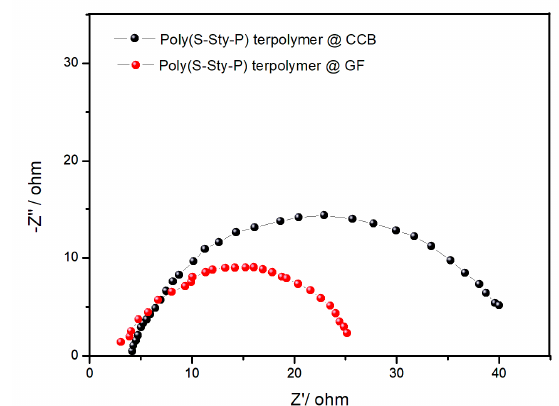
Figure 13. The electrochemical impedance spectroscopy (EIS) of poly(S-Sty-P) terpolymer @ CCB cathode material and poly(S-Sty-P) terpolymer @ GF cathode material.